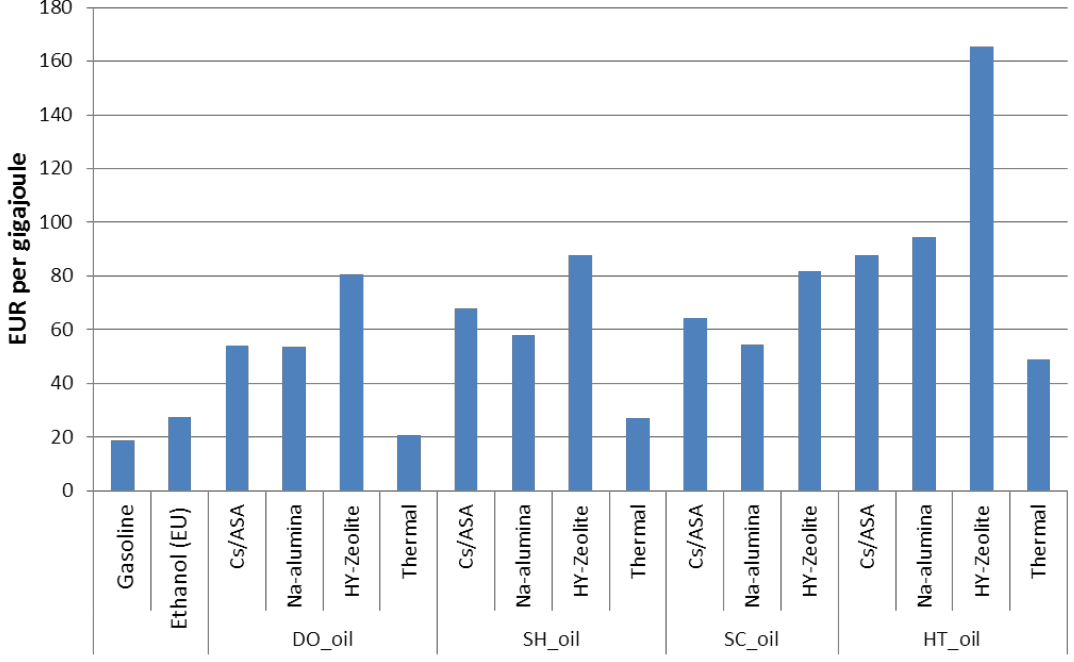
Figure 5. Comparison of the minimum viable price of pyrolysis biofuel from four cases and four scenarios, with market prices for gasoline and ethanol without excise taxes.